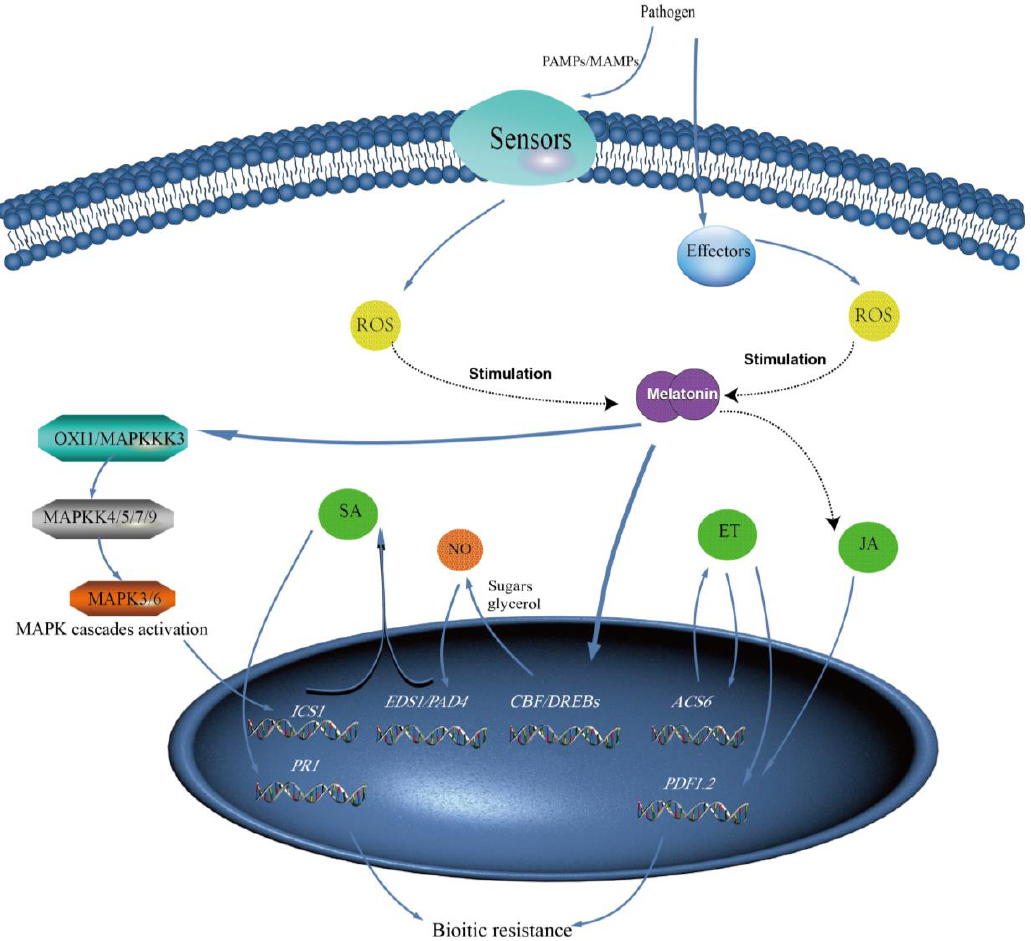
Figure 3. Melatonin-mediated biotic stress response in plants. Abbreviation: ROS, reactive oxygen species; PAMPs, pathogen-associated molecular patterns; MAMPs, microbe-associated molecular patterns; MAPK, Mitogen-activated protein kinase; NO, nitric oxide; SA, salicylic acid; JA, jasmonic acid; ET, ethylene. Dotted arrows represent the hypothetical pathway.